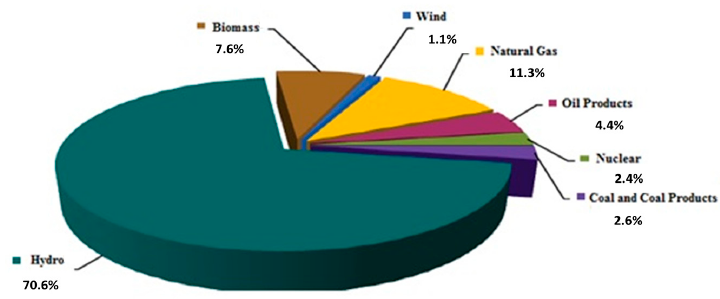
Figure 1. Internal offer of electric energy by generation source.